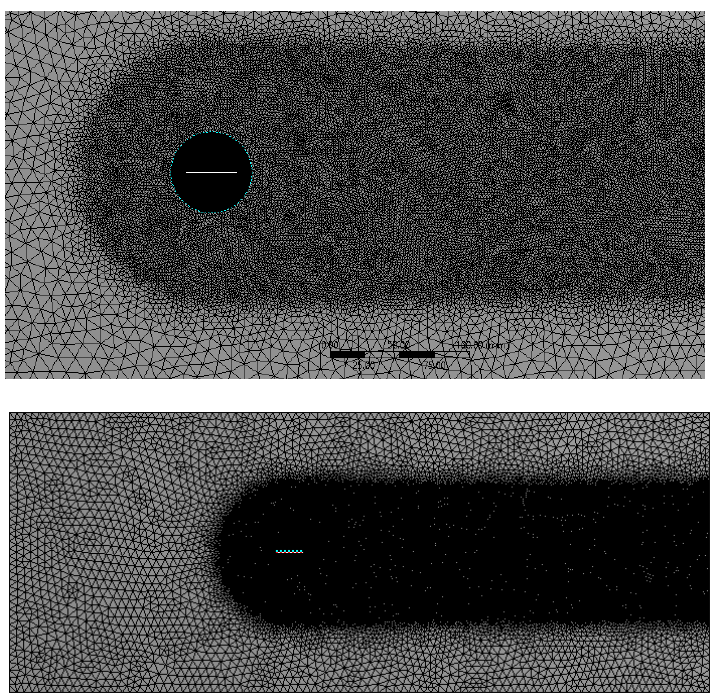
Figure 13. Boundary layer inflation zone in close proximity to the flat plate.